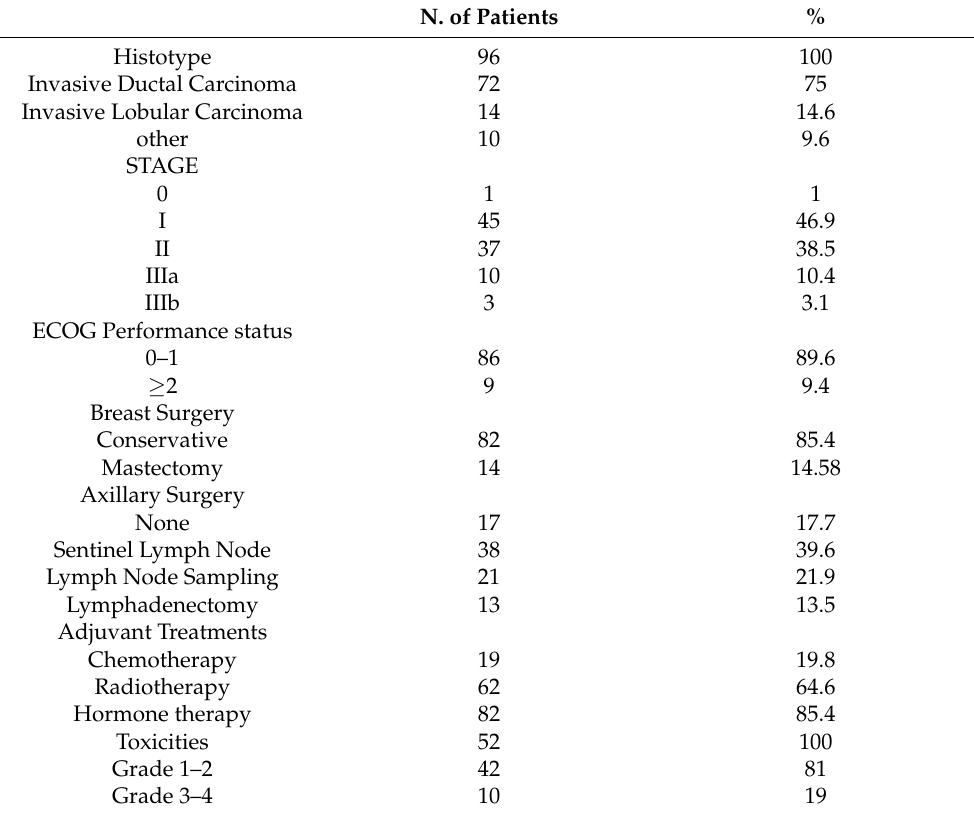
Table 2. Characteristics of the study population.